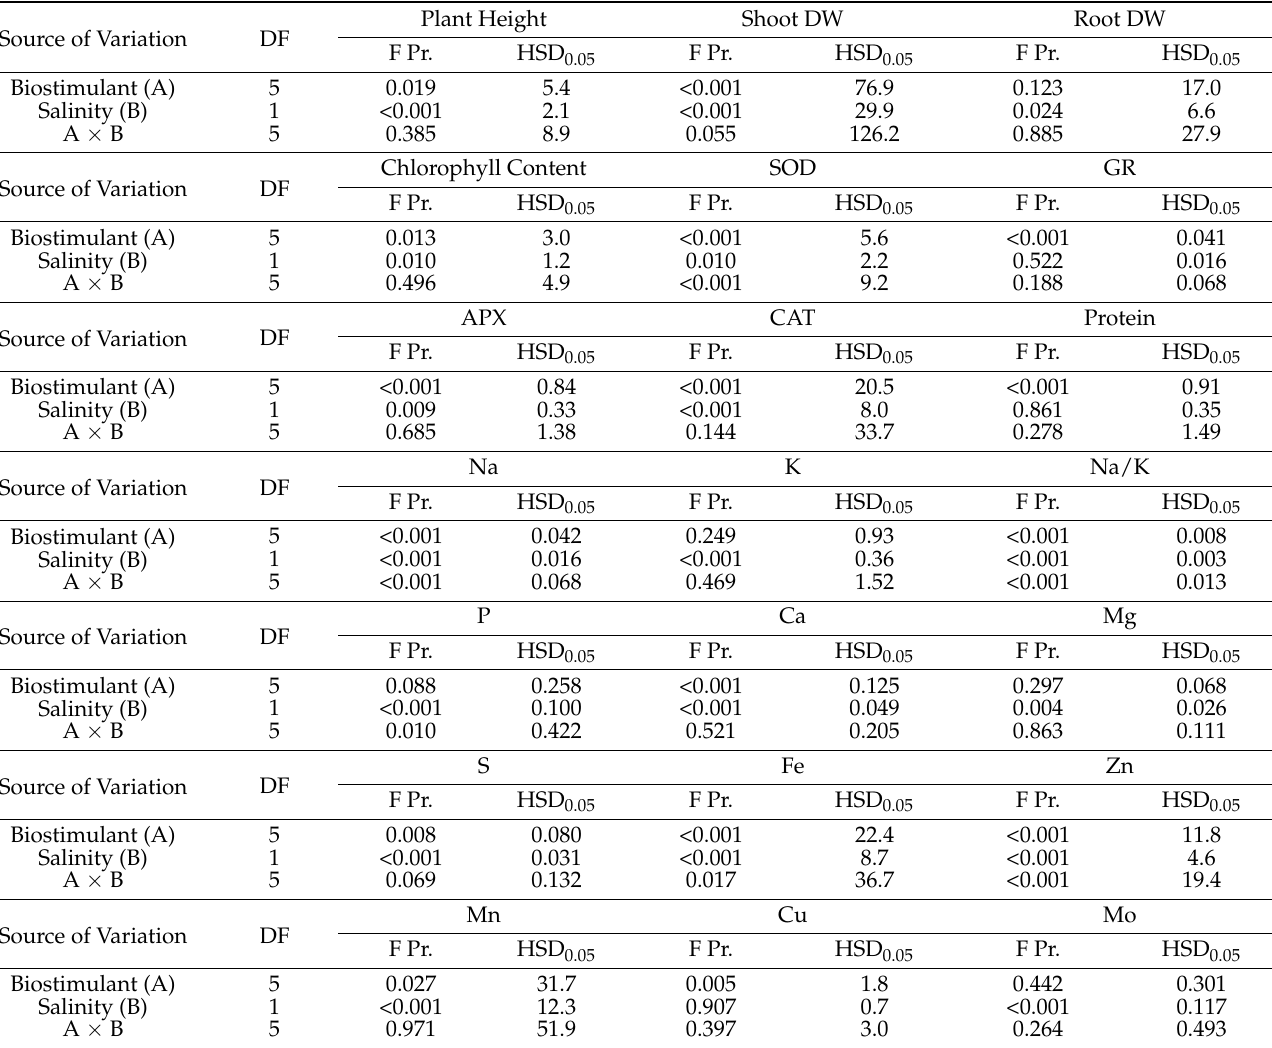
Table 1. Significance of the effects of biostimulants (A), salinity (B) and their interactions on reported traits of hydroponically grown maize ( Zea mays cv. Caramelo) plants (30 days after sowing (DAS)) according to two-way analysis of variance (ANOVA) ( α =